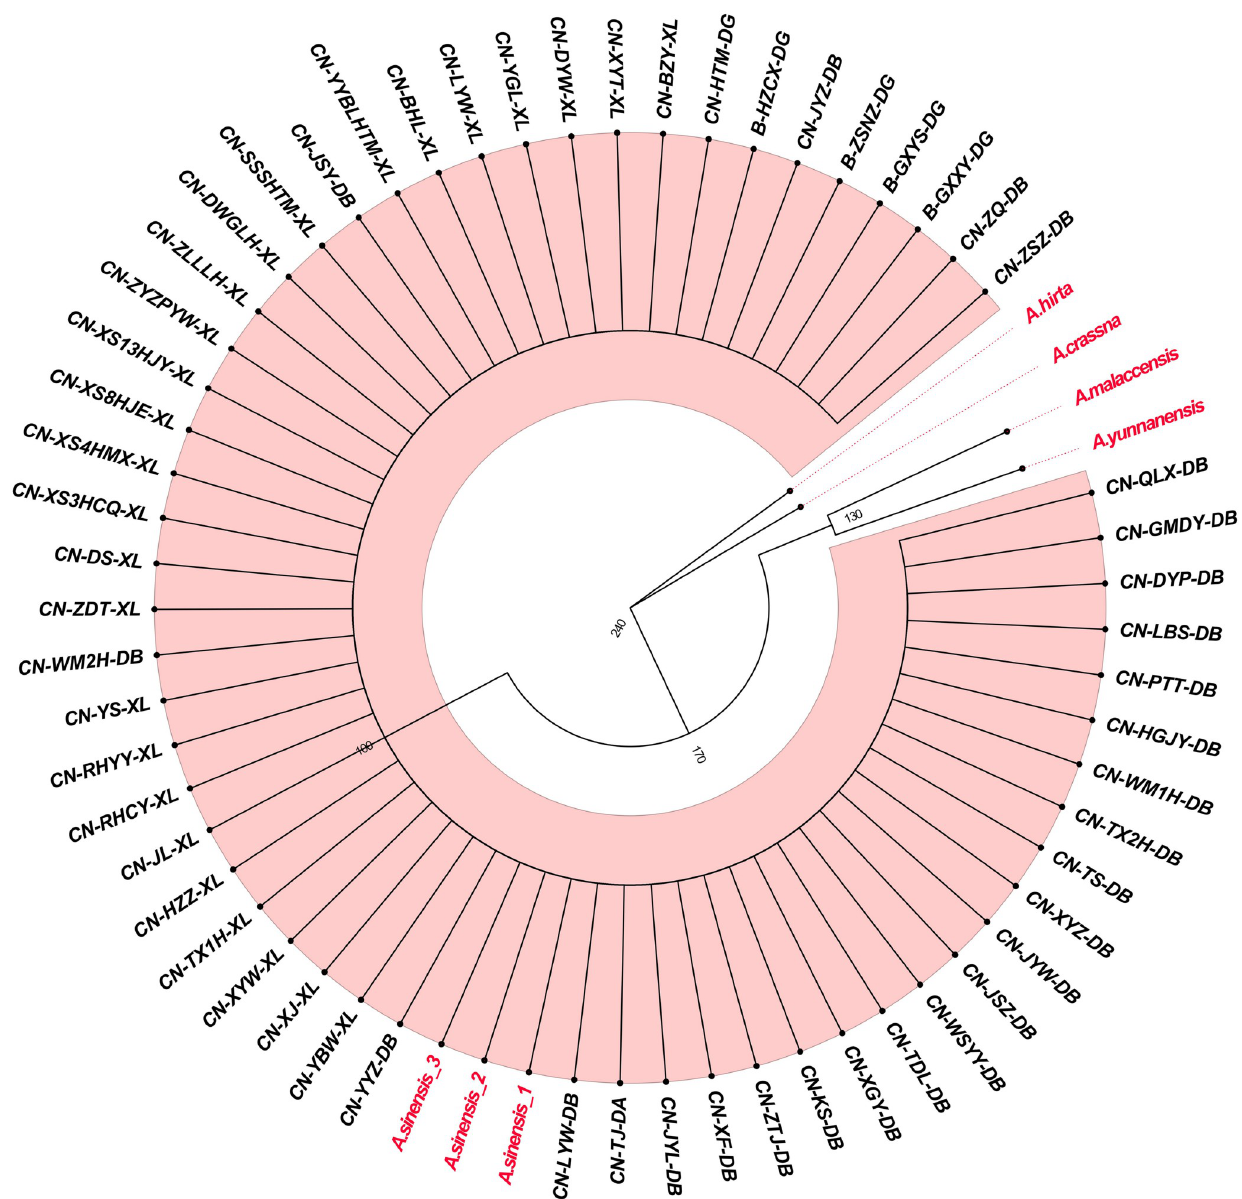
Fig 6. The phylogenetic tree of the 58 Qi-Nan germplasms and five Aquilaria species, constructed with maximum likelihood and the ITS2 + matK combination.